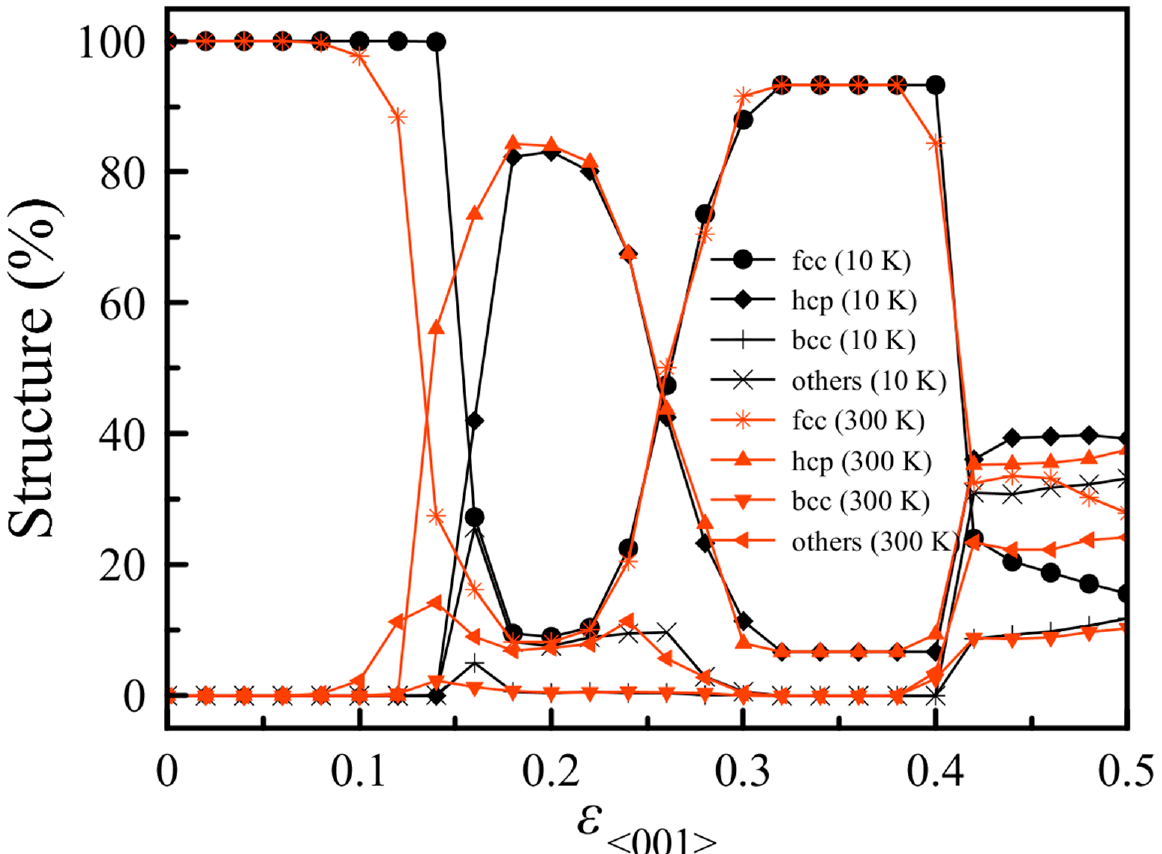
Figure 7. Structural evolution for uniaxial compressive loading of TiAl alloy in the <001> direction. The black and red circles represent the loading process at 10 and 300 K, respectively.